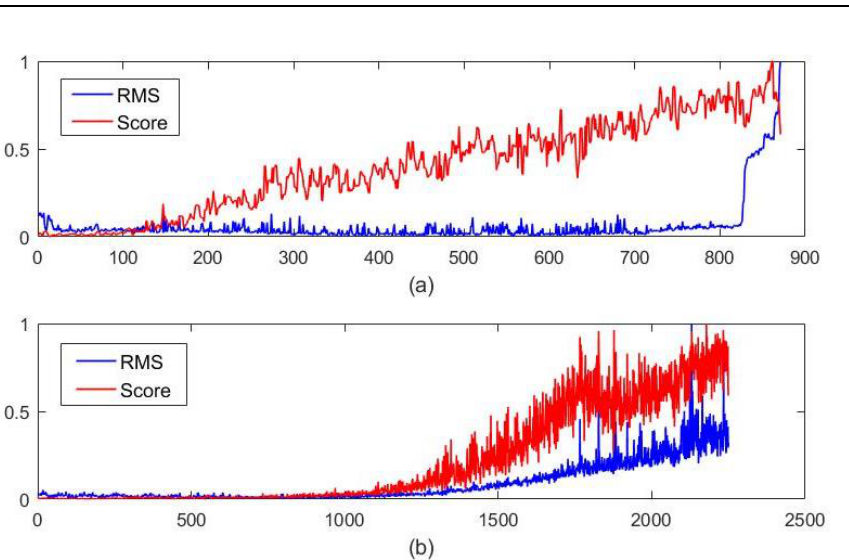
Figure 4. Result comparison of abnormal score and the RMS value with ( a ) PHM1_2 and ( b ) PHM1_3.